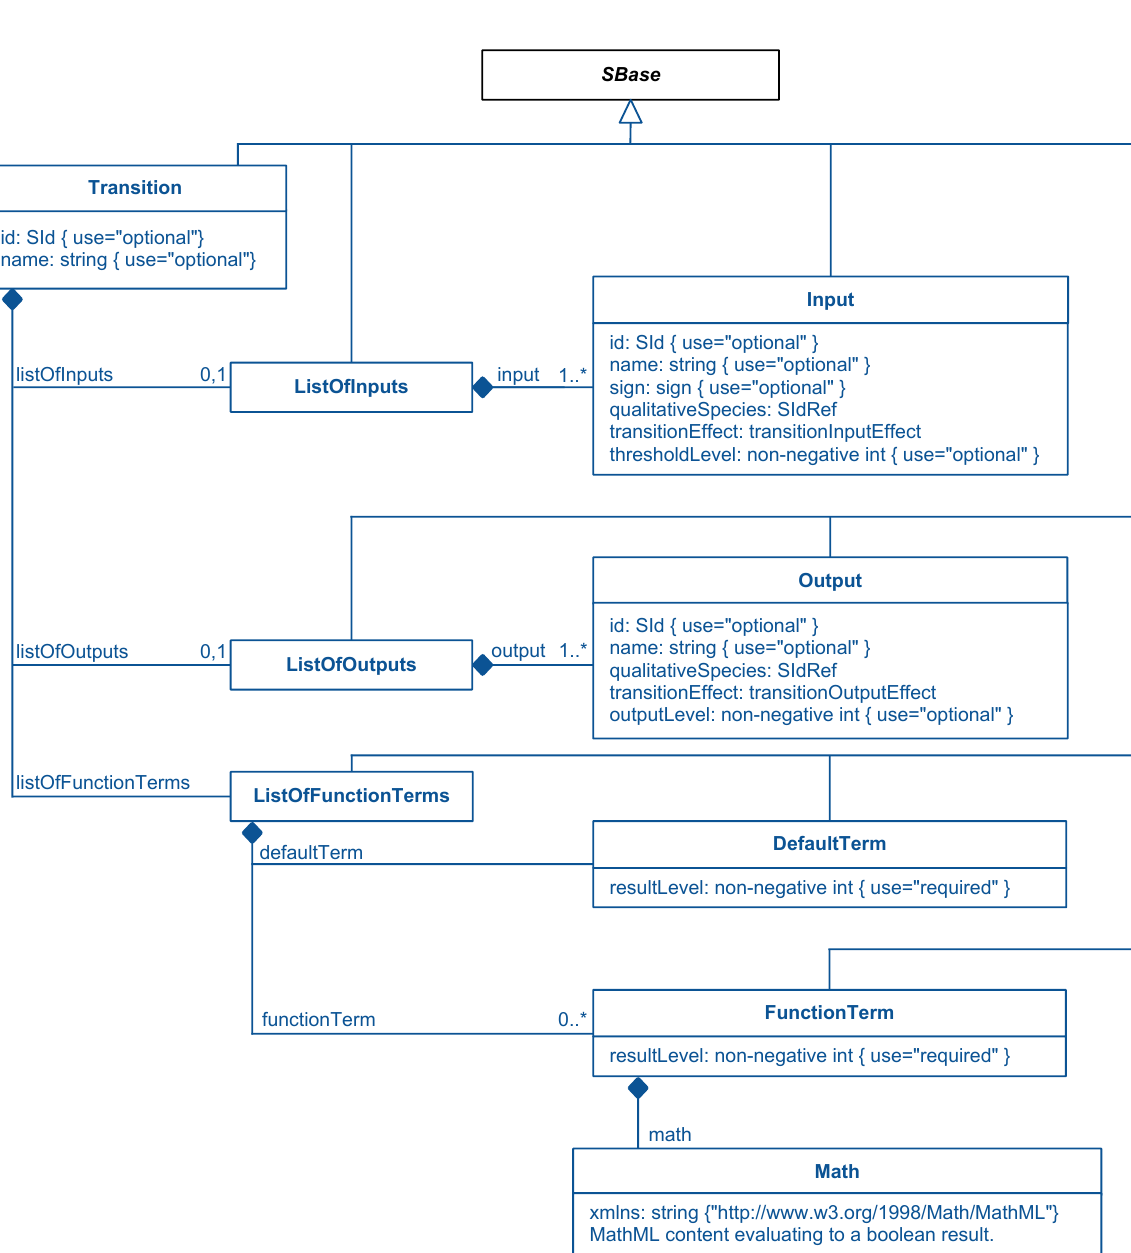
Figure 3: The definitions of Transition , Input , Output , DefaultTerm and FunctionTerm classes. Note that the Default- Term class is not derived from